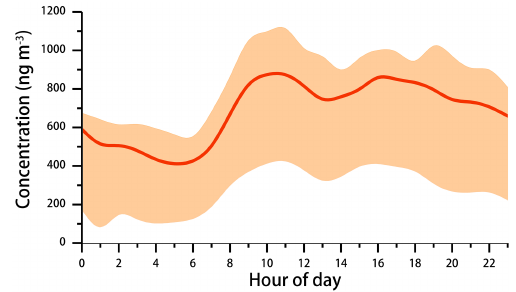
Figure 4. Diurnal variation of PMF-derived elemental concentra- tion for factor 1. The red line, bottom boundary and upper boundary represent the mean, 1st quartile and 3rd quartile of the concentration value,